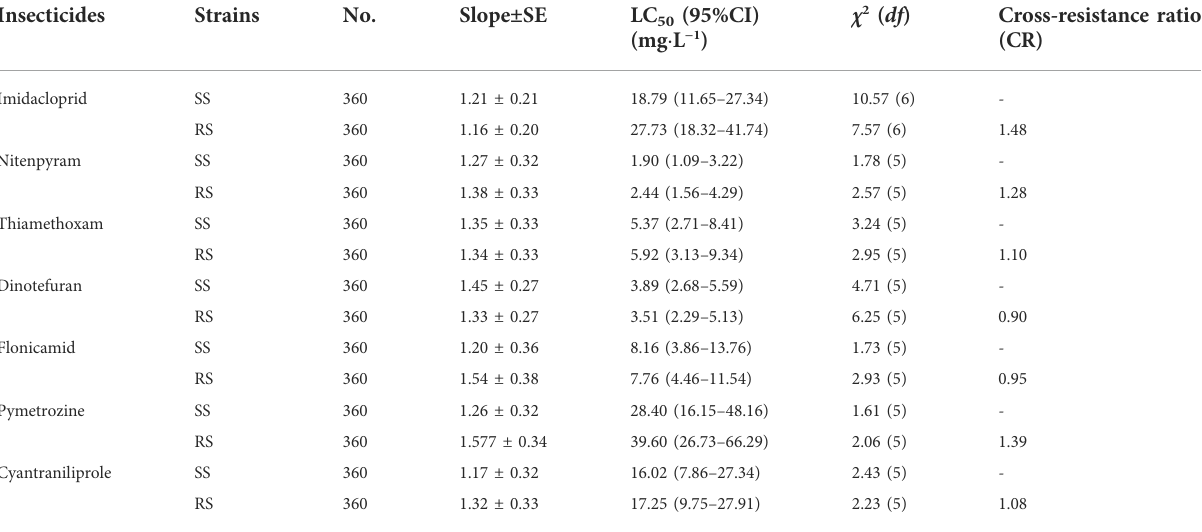
TABLE 4 Cross-resistance of SS and RS strains of SBPH to seven insecticides.